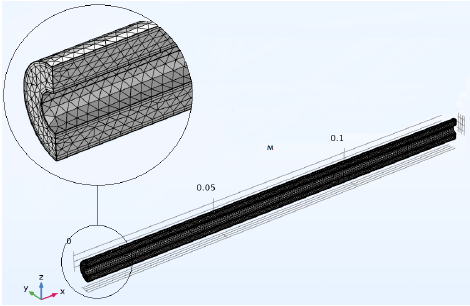
Figure 5. Geometrical model mesh.